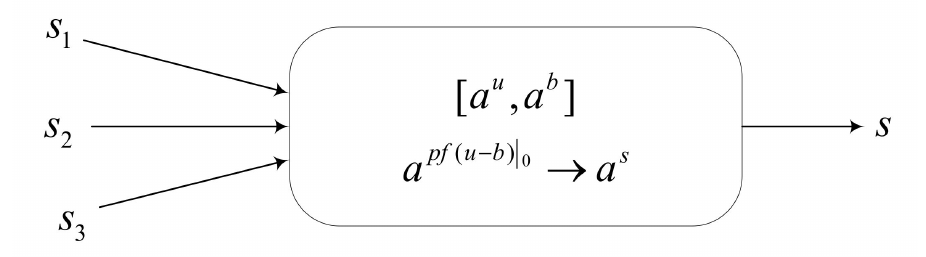
Figure 2. The neuronal structure of an SNMC